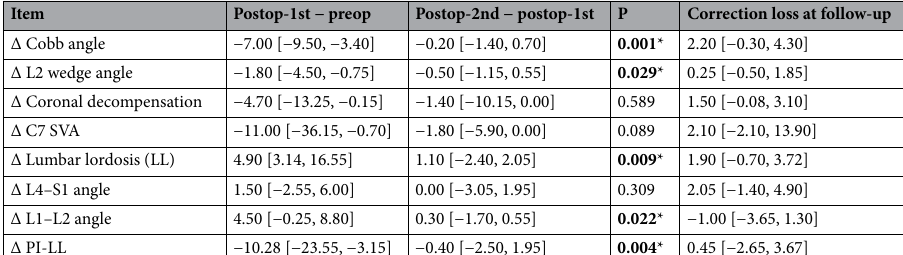
Table 2. Changes in radiological parameters in two-stage surgery. Data are shown as median [interquartile range]. SVA sagittal vertical axis, PI pelvic incidence. *Significant differences for postop-1st vs. preop and postop-2nd vs.